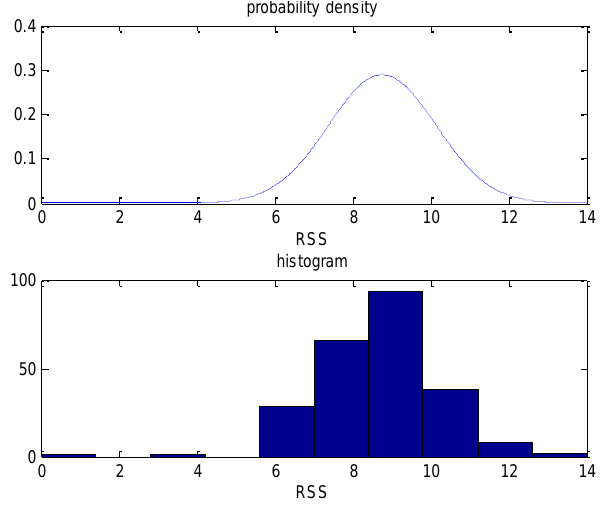
Figure 3. The distribution of the received signal strength at a fixed